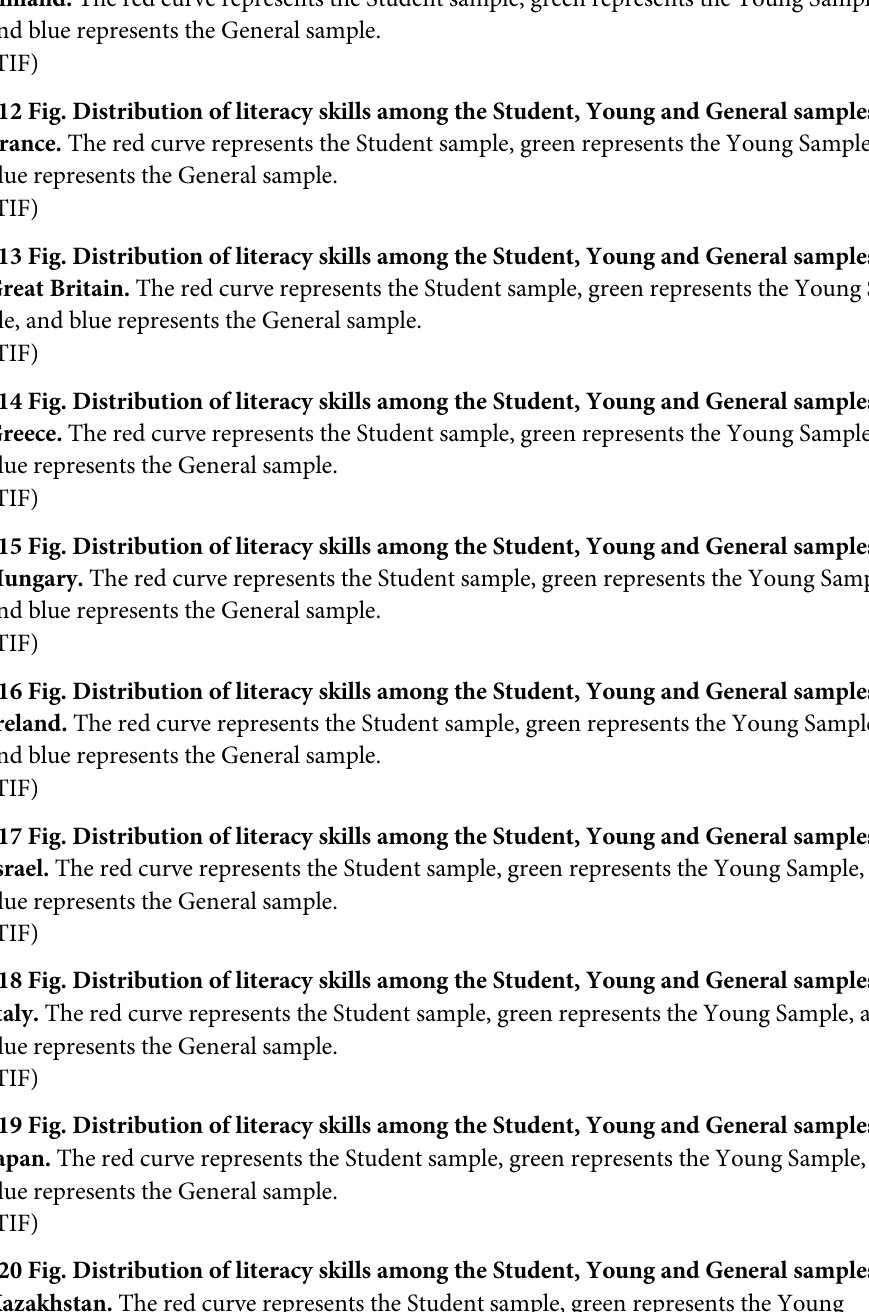
S10 Fig. Distribution of literacy skills among the Student, Young and General samples of Estonia. The red curve represents the Student sample, green represents the Young Sample, and blue represents the General sample. (TIF) S11 Fig. Distribution of literacy skills among the Student, Young and General samples of Finland. The red curve represents the Student sample, green represents the Young Sample, and blue represents the General sample. (TIF) S12 Fig. Distribution of literacy skills among the Student, Young and General samples of France. The red curve represents the Student sample, green represents the Young Sample, and blue represents the General sample. (TIF) S13 Fig. Distribution of literacy skills among the Student, Young and General samples of Great Britain. The red curve represents the Student sample, green represents the Young Sam- ple, and blue represents the General sample. (TIF) S14 Fig. Distribution of literacy skills among the Student, Young and General samples of Greece. The red curve represents the Student sample, green represents the Young Sample, and blue represents the General sample. (TIF) S15 Fig. Distribution of literacy skills among the Student, Young and General samples of Hungary. The red curve represents the Student sample, green represents the Young Sample, and blue represents the General sample. (TIF) S16 Fig. Distribution of literacy skills among the Student, Young and General samples of Ireland. The red curve represents the Student sample, green represents the Young Sample, and blue represents the General sample. (TIF) S17 Fig. Distribution of literacy skills among the Student, Young and General samples of Israel. The red curve represents the Student sample, green represents the Young Sample, and blue represents the General sample. (TIF) S18 Fig. Distribution of literacy skills among the Student, Young and General samples of Italy. The red curve represents the Student sample, green represents the Young Sample, and blue represents the General sample. (TIF) S19 Fig. Distribution of literacy skills among the Student, Young and General samples of Japan. The red curve represents the Student sample, green represents the Young Sample, and blue represents the General sample. (TIF) S20 Fig. Distribution of literacy skills among the Student, Young and General samples of Kazakhstan. The red curve represents the Student sample, green represents the